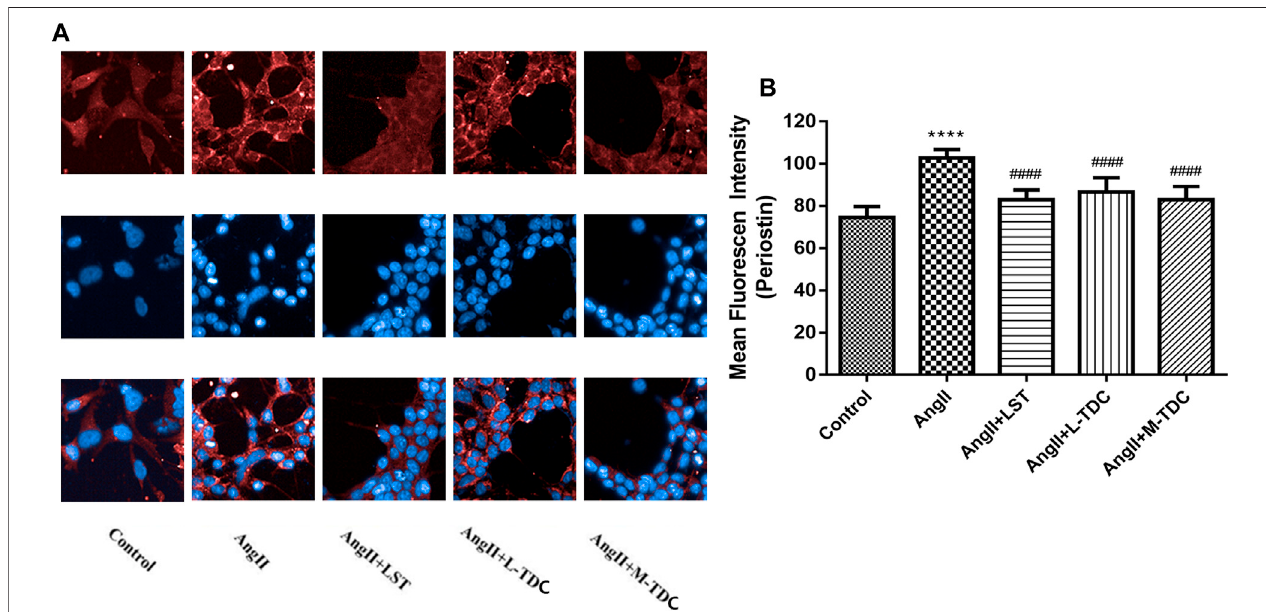
FIGURE7| EffectofTDConperiostinexpressioninAngII-treatedHEK293cells (A) Representativeimmuno fl uorescencestainimages( × 200magni fi cation)ofanti- periostinantibody(top,red),nucleus(middle,blue),andmerge(bottom).LST:positive-controldruglosartan(1 μ mol/l);L-TDC:lowdoseofTDC(0.0138 mg/ml);M-TDC: medium dose of TDC (0.0553 mg/ml) (B) Quantitation of IF results from three independent experiments. Data are expressed as mean ± SD, n (cid:2) ,3. ### p , < ,0.001 vs. Control; *** p , < ,0.001, vs. Ang Ⅱ -induced HEK293 cells.